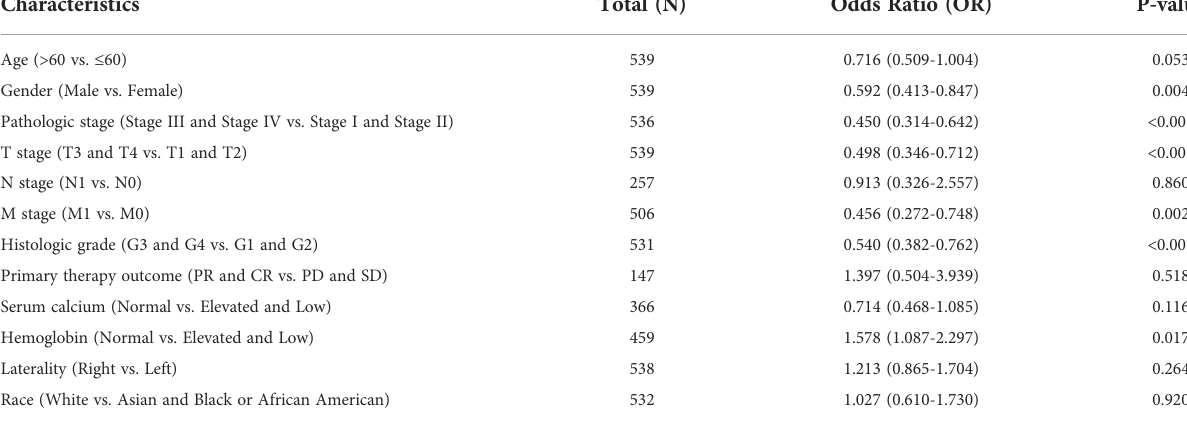
TABLE 2 IREB2 single-gene logistics